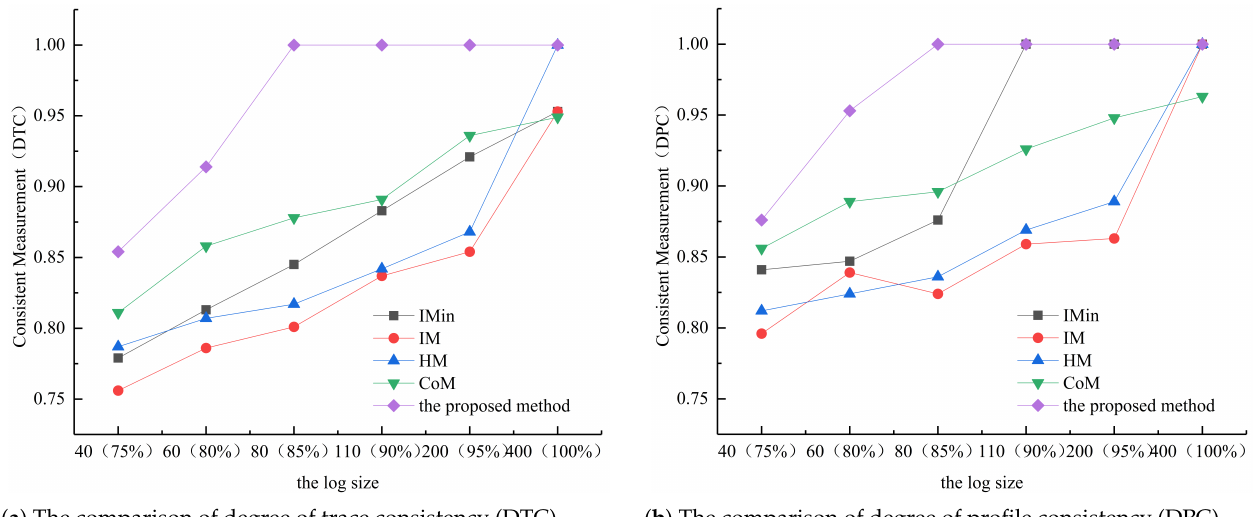
Figure 13. The degree of consistency